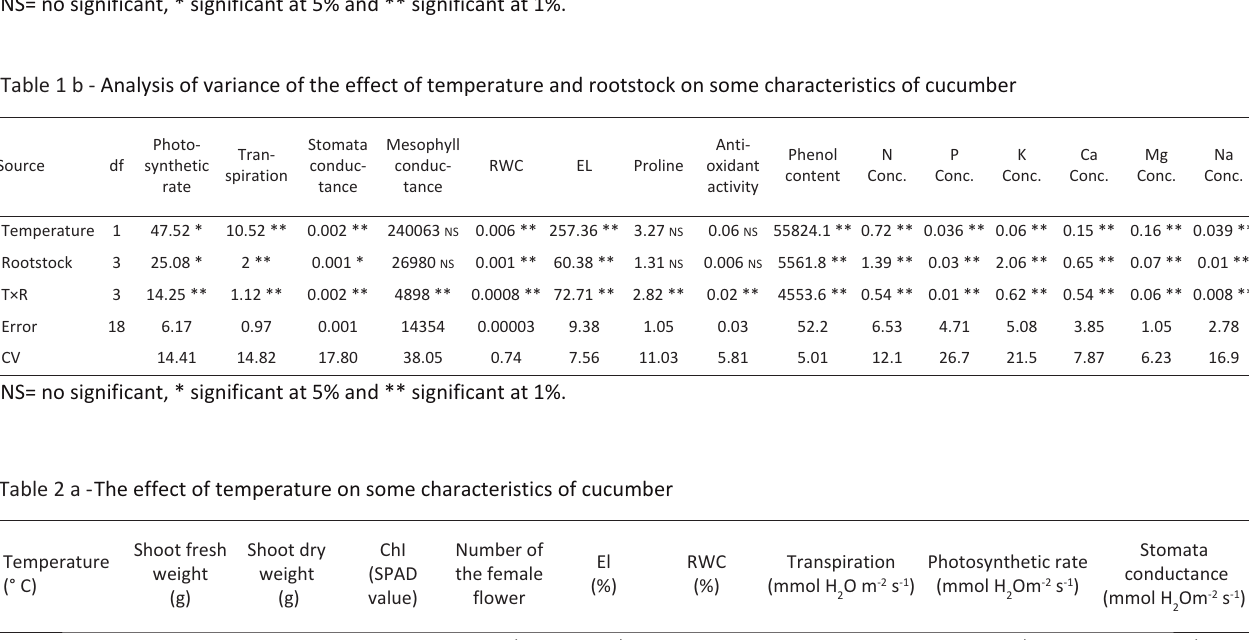
NS= no significant, * significant at 5% and ** significant at 1%.